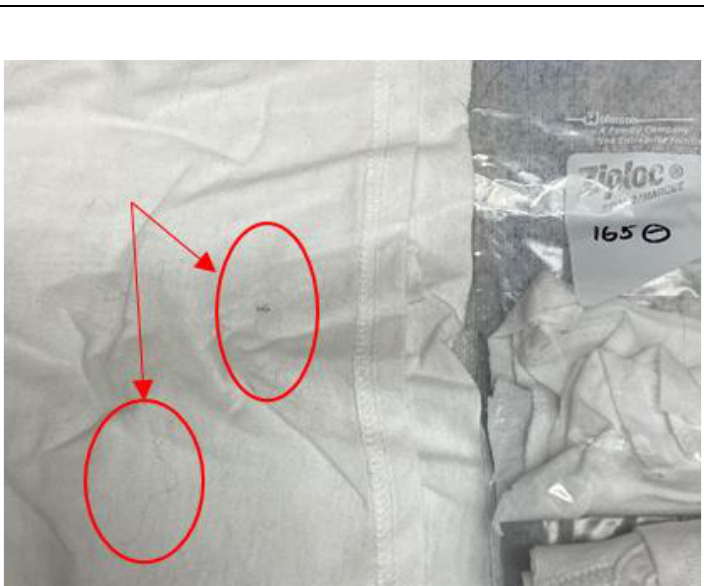
Figure A1. Image of COVID T-shirt for sample #165 containing animal fur.